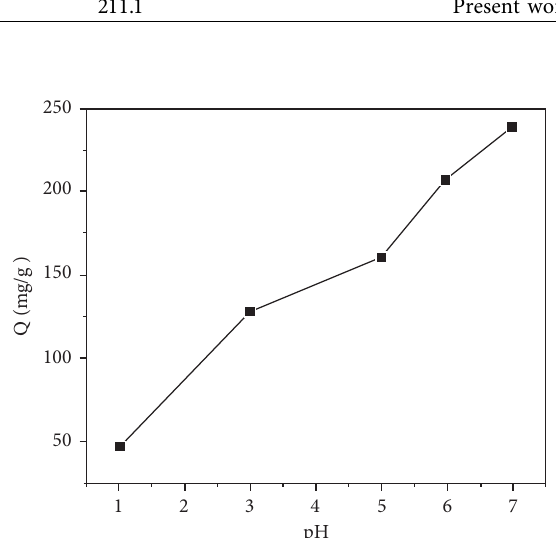
Figure 10: Effect of initial pH on Co(II) removal of the GTNT